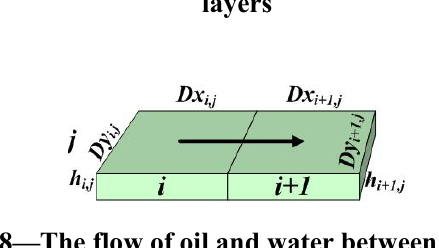
Figure 8—The flow of oil and water between two